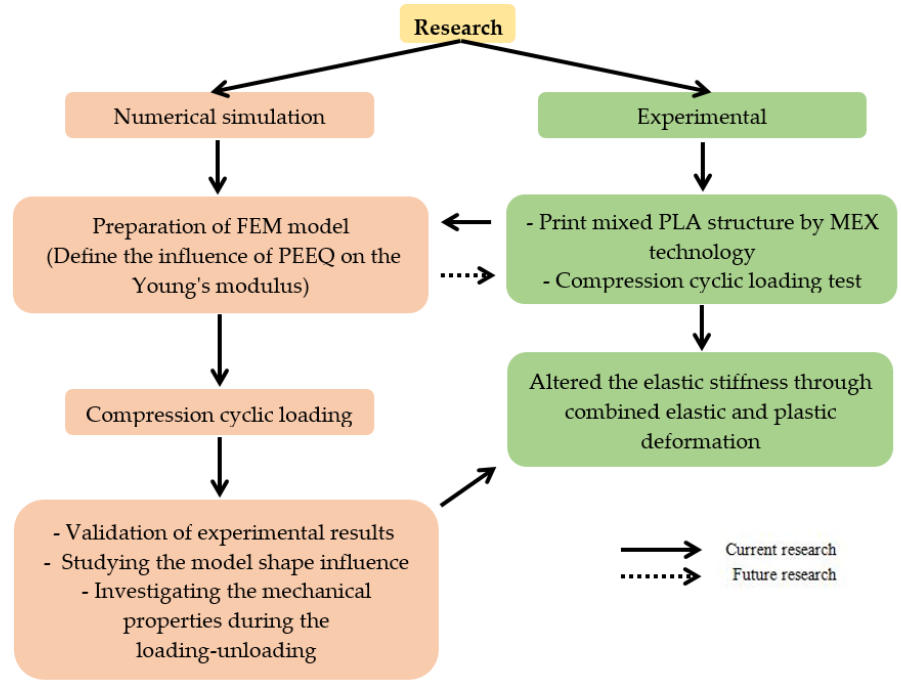
Figure 2. A summary of the research in the experimental part [35] and the validation of the experi- mental results using numerical simulations.